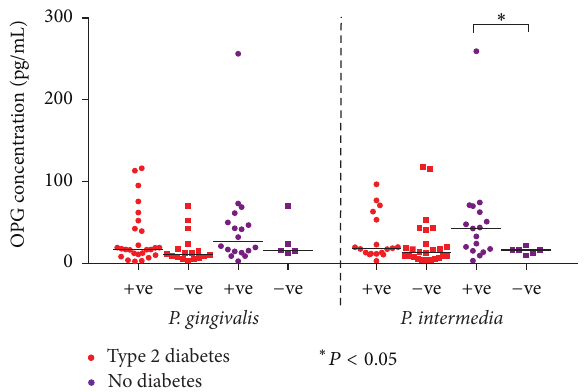
Figure 5: Distribution of salivary OPG concentrations (pg/mL) according to the prevalence of P. gingivalis and P. intermedia in subjects with and without type 2 diabetes regardless of the periodontal status ( 𝑛 = 80